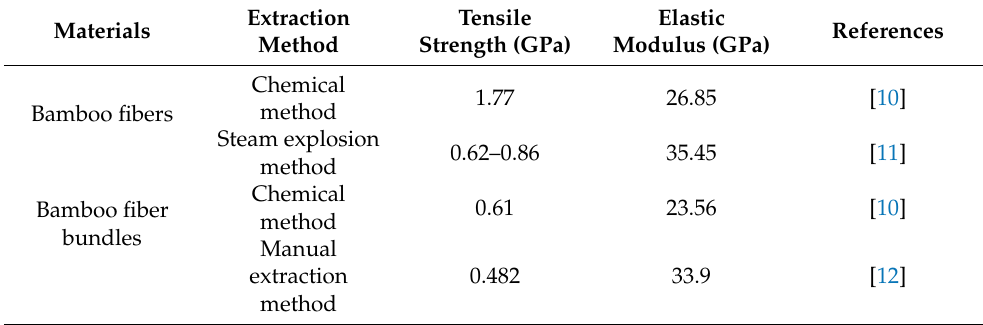
Table 1. Extraction methods and mechanical properties of bamboo fibers and fiber